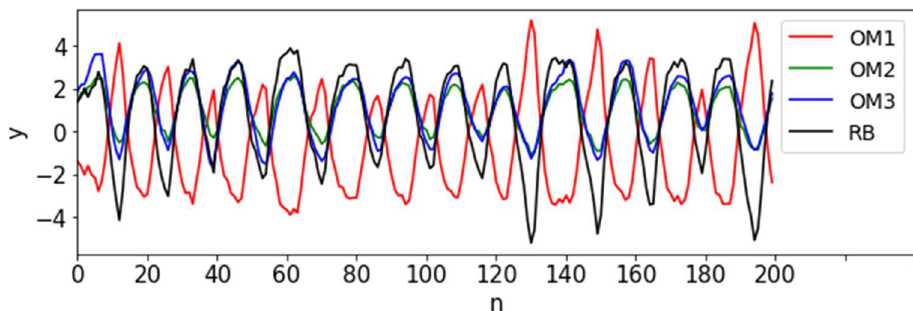
Figure 4. Time-series signals of the 4 tasks from the OM dataset. x -axis: n is the number of data points.